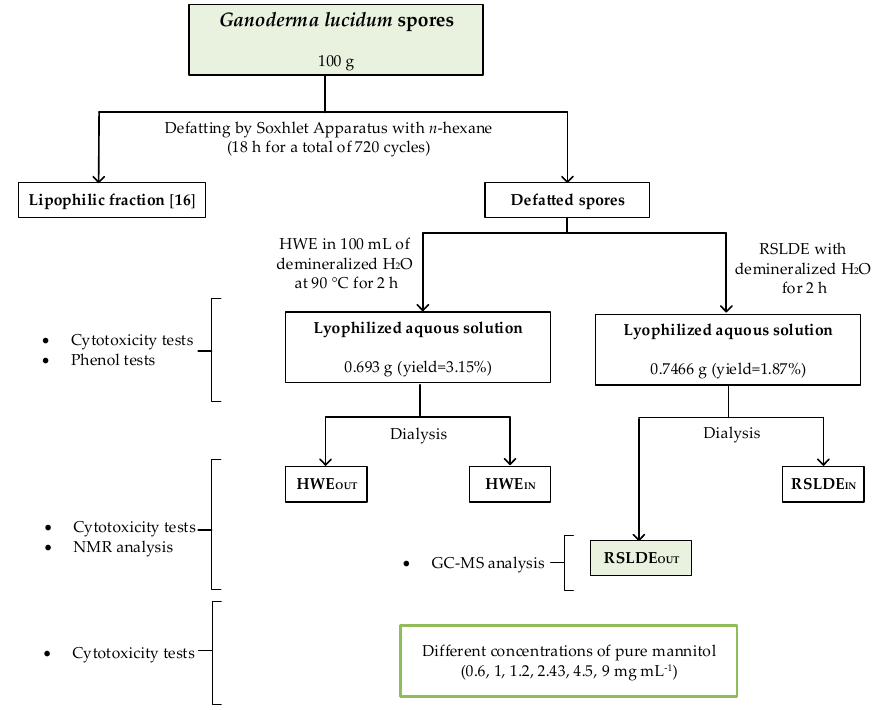
Figure 1. Schematic representation of the analysis performed on the defatted spores of G. lucidum